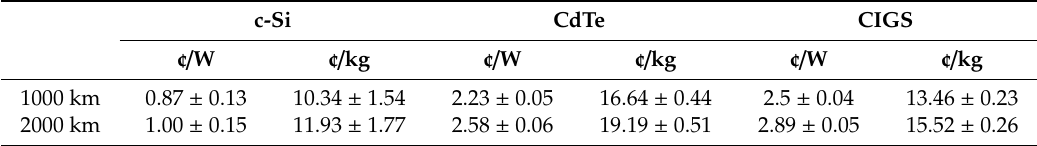
Table 4. Average cost of transportation of different PV technologies.